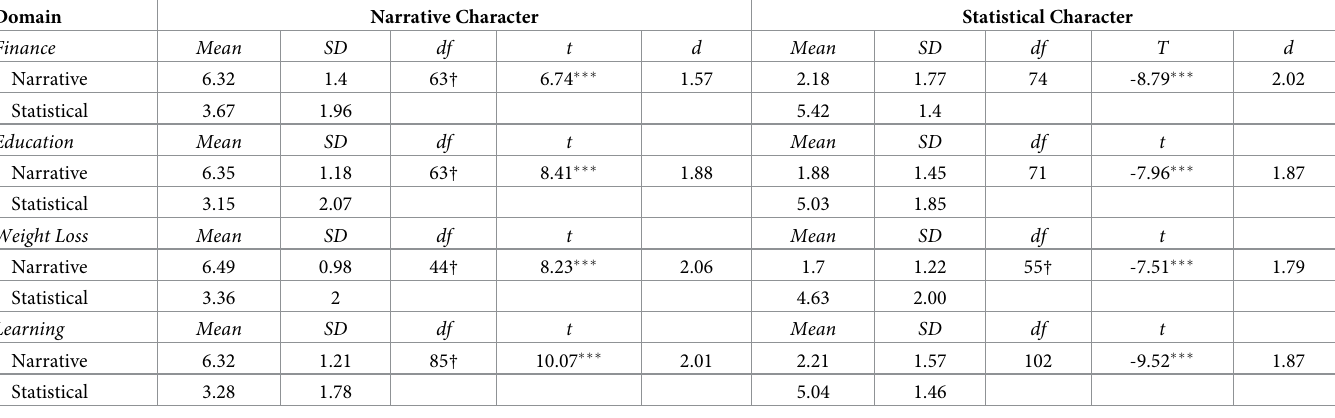
Table 2. Narrative and statistical character judgments for arguments across